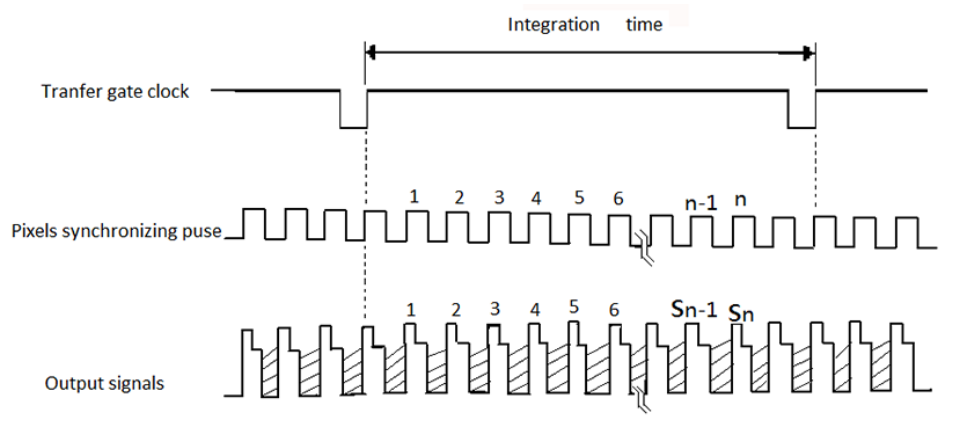
Figure 3. Timing diagram for the photoelectric signals acquisition of the line CCD